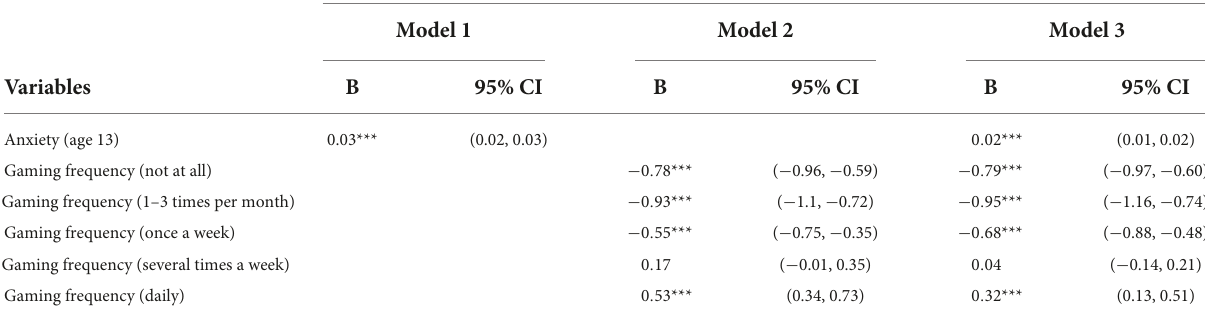
TABLE 4 Multiple linear regression analyses using anxiety levels (age 13) and gaming frequency (age 13) to predict gaming disorder symptoms (age 14).